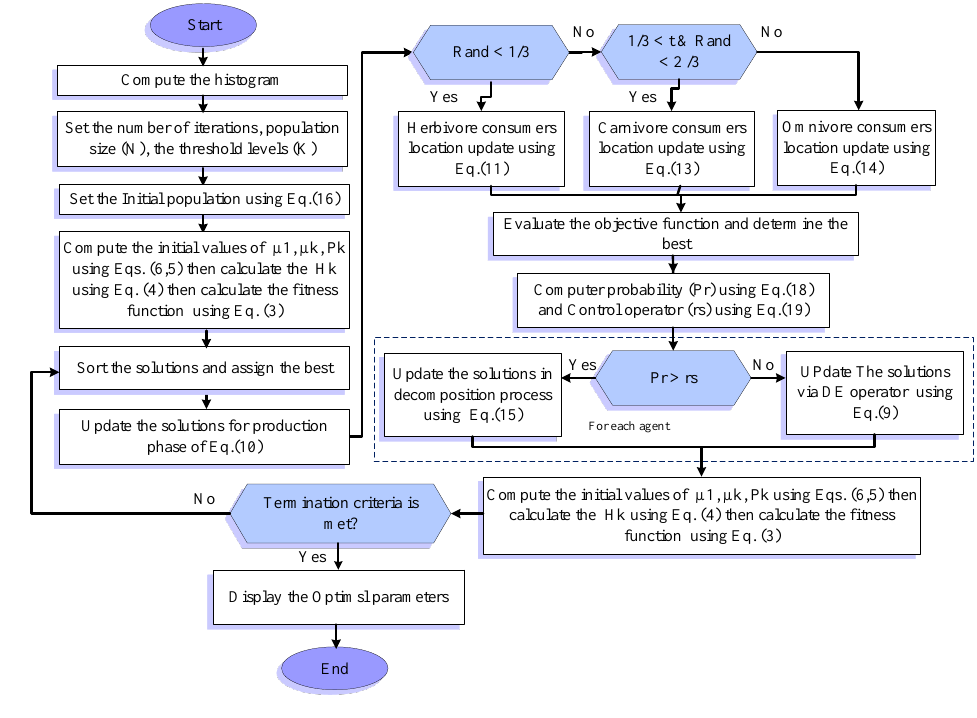
Figure 1. The flowchart of the